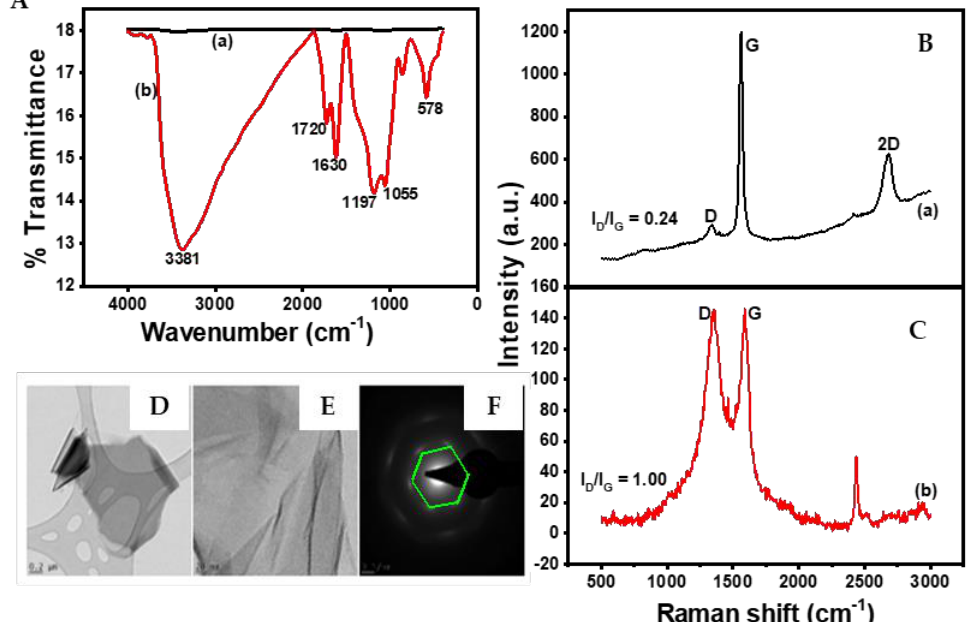
Figure 1. Structural and morphological characterizations of graphite (a) and GO (b); FTIR ( A ), Raman spectra of graphite ( B ) and GO ( C ), and HRTEM of graphite ( D ) and GO ( E ) with accompanying SAED of GO and highlighted diffraction pattern ( F